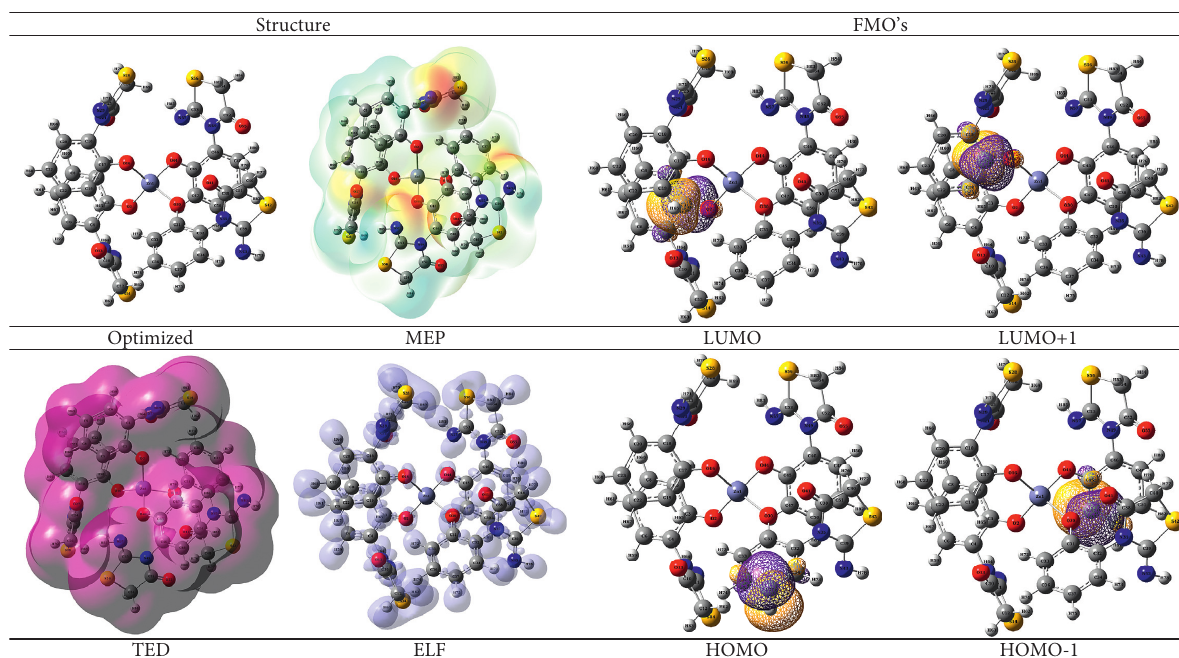
Figure 4: Optimized structure, FMOs, surfaces, and ELF plots of ZnL1.